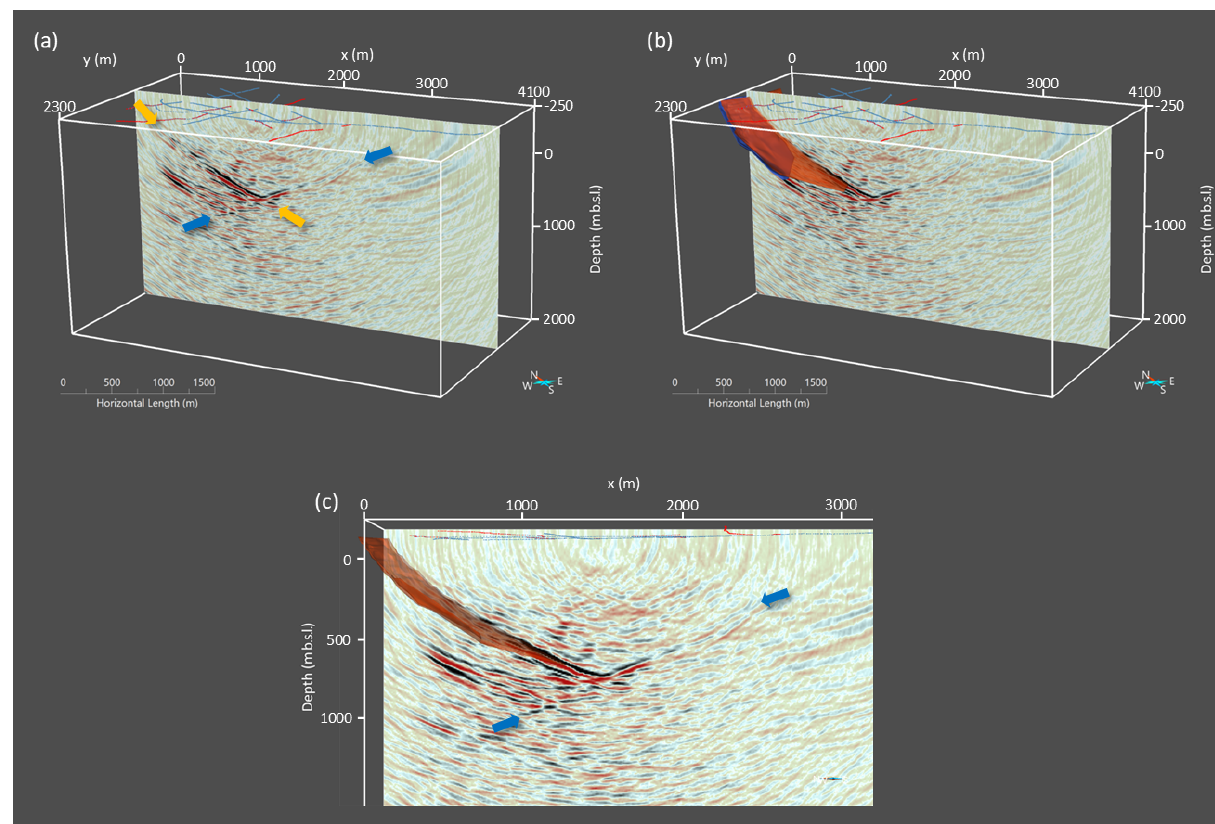
Figure 7. The same depth slices as in Fig. 6 shown through the FVM result using the 1D migration velocity model and including information from MVA (Table 1) presented (a) without and (b) with the known mineralization in red and blue. The arrows in (a) mark the image of the main mineralization reflector and a crosscutting reflector dipping in the opposite direction (compare Fig. 6c and d). Panel (c) shows a frontal view of the important portion of (b) together with the main mineralization in